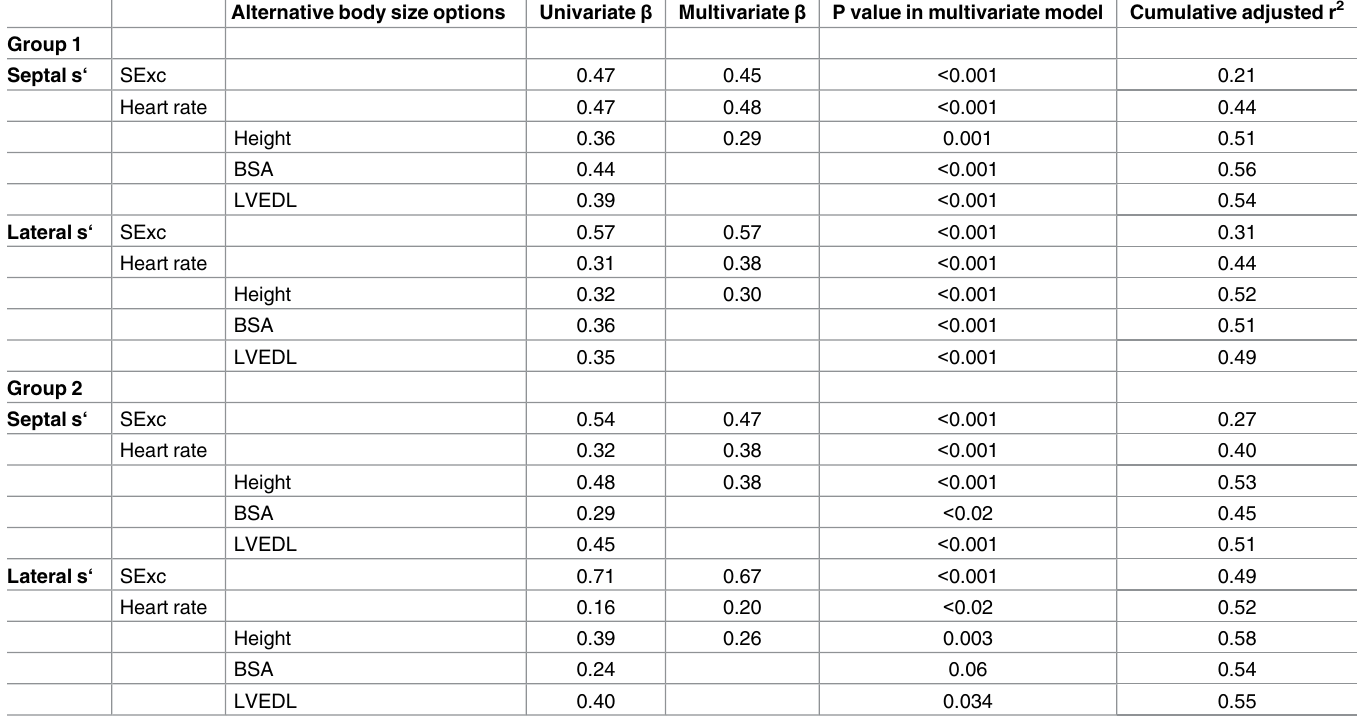
Table 6. Linear regression analysis of s‘ with systolic excursion, heart rate, body size and left ventricular diastolic length.